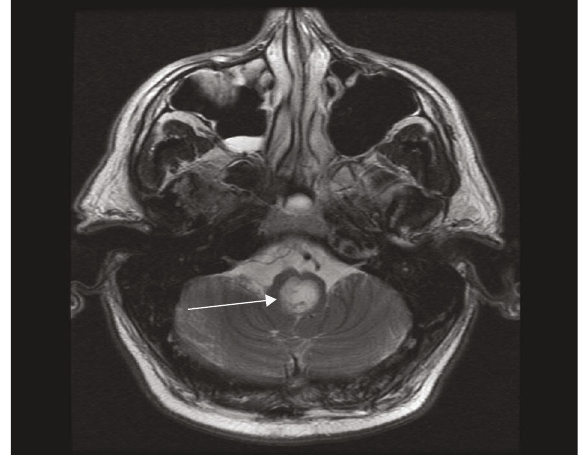
Figure 2: Preoperative MR brain T2-weighted axial image demonstrates a large cyst in the caudal medulla.